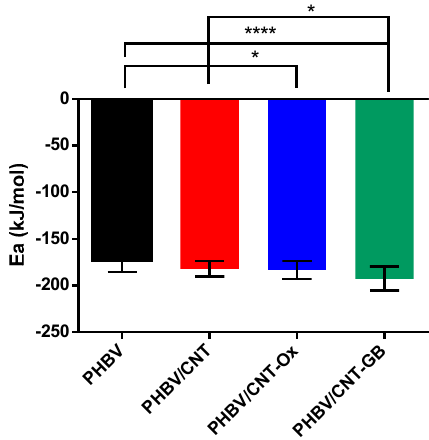
Figure 5. Statistical analysis of activation energy data for PHBV, PHBV/CNT, PHBV/CNT-Ox, and PHBV/CNT-GB.